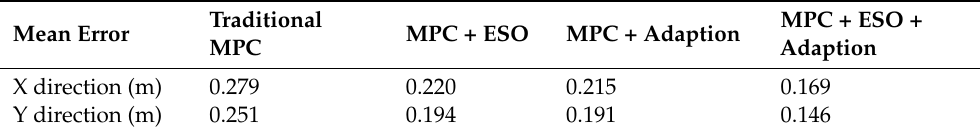
Table 3. The average errors of the whole process with 0.2 m/s disturbance velocities in both the X and Y